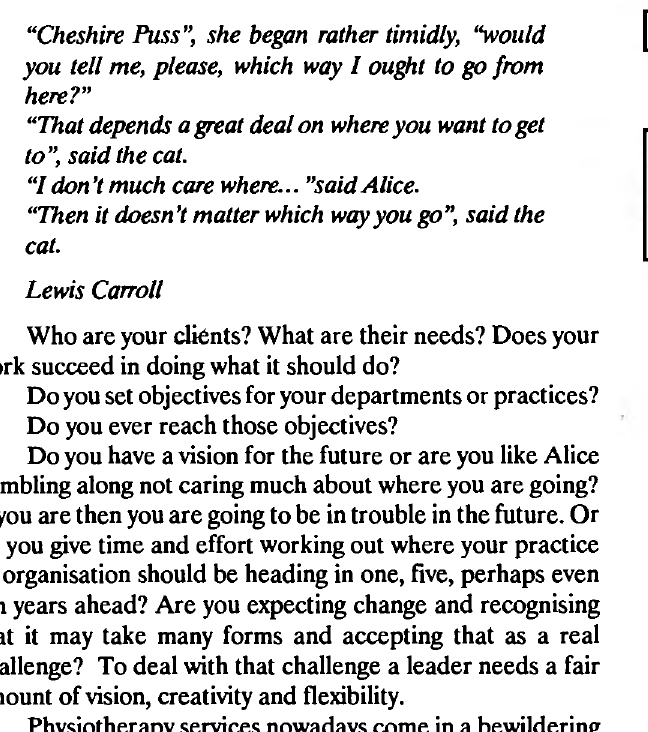
Figure 1: THE ORGANISATION AS A SYSTEM